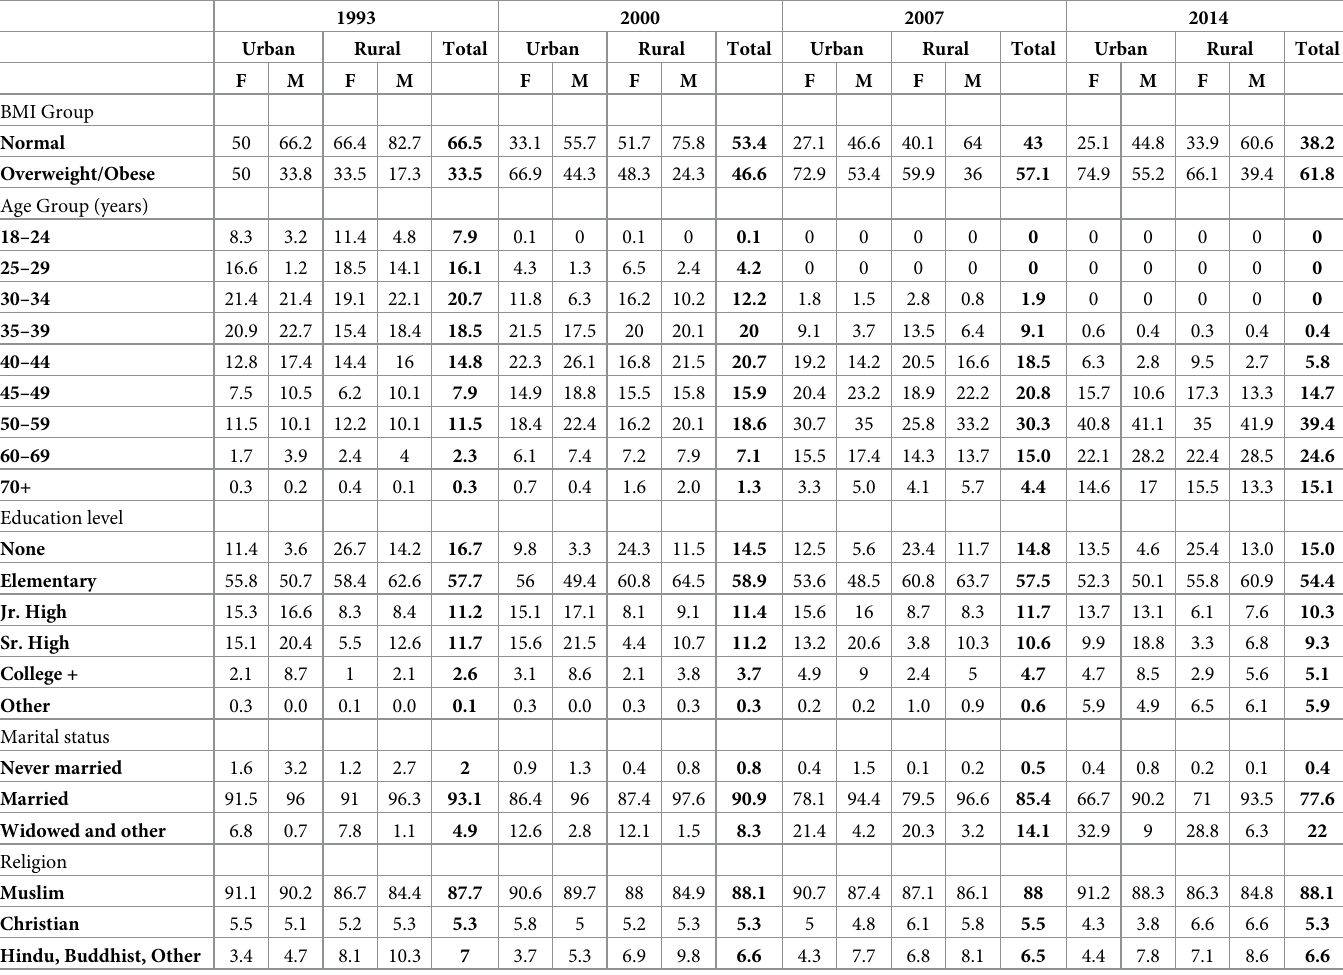
Table 2. Sample proportions by panel year, residence, and